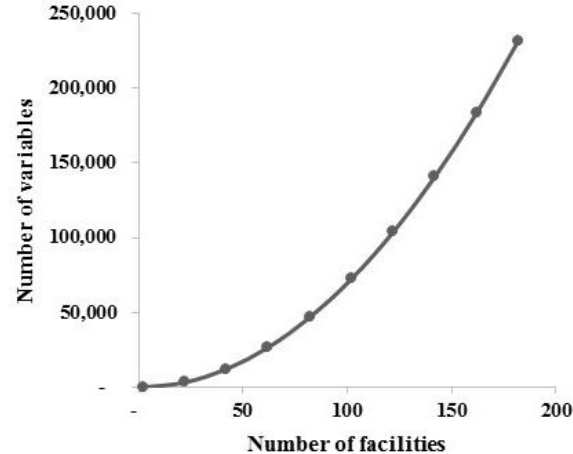
Figure 2. CLITraP-HTF total number of decision variables.